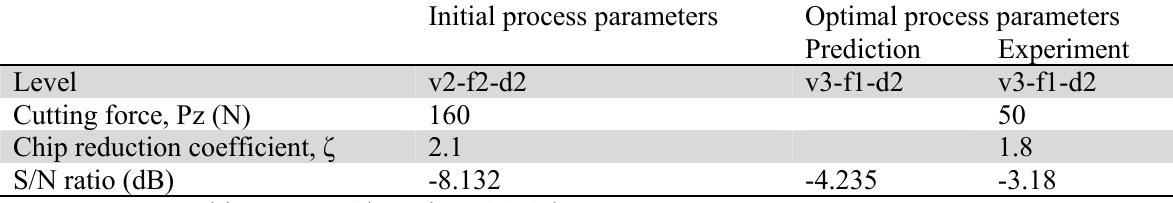
Results of the confirmation experiment for case-1 (w 1 = 7, w2 = 3)